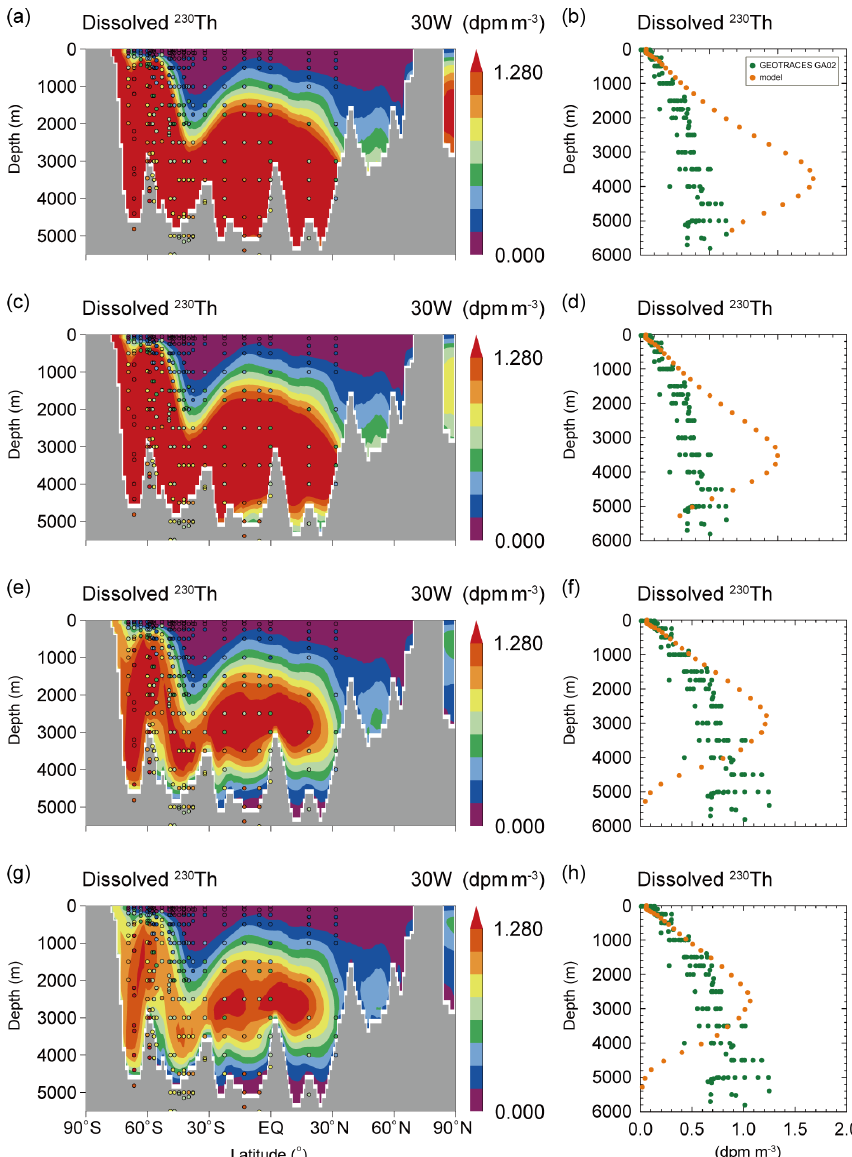
Figure 3. (a, c, e, g) Dissolved 230 Th along 30 ◦ W in the Atlantic Ocean and (b, d, f, h) its vertical profile (the latitudinal mean along 30 ◦ W is set to 5 . 0 × 10 5 in (a) and (b) , 1 . 0 × 10 6 in (c) and (d) , 5 . 0 × 10 6 in (e) and in the Atlantic Ocean) in BTM_EXP are plotted. K Th bottom (f) , and 1 . 0 × 10 7 in (g) and (h) . The colored circles in (a) , (c) , (e) , and (g) represent data from the Atlantic GEOTRACES data (GA02 and GIPY05; Schlitzer et al., 2018). The green and orange circles in (b) , (d) , (f) , and (h) represent the GA02 data and simulation results.